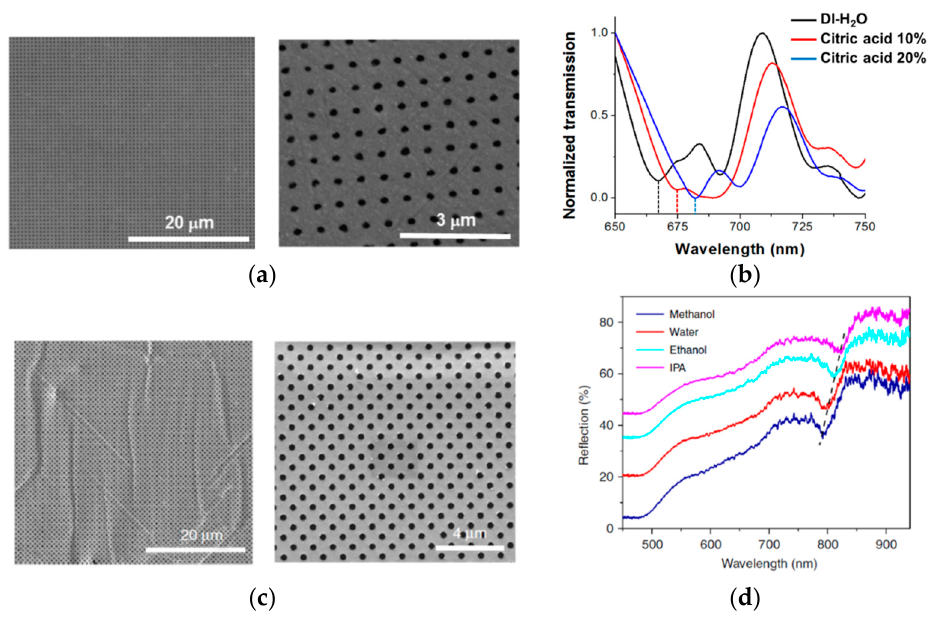
Figure 5. Scanning electron microscope photographs of a 625-nm-period Al nanohole array (NHA) ( a ) and a 600-nm-period Au NHA ( c ) transferred onto Scotch adhesive tapes. Both nanostructured surfaces exhibit excellent uniformity over large areas. Spectral transmission ( b ) and reflection ( d ) of the NHAs shown in ( a , c ), respectively, when immersed in liquid solutions having different refractive indices. Spectral features used as the refractive index sensor response are indicated with dotted lines in both ( b , d